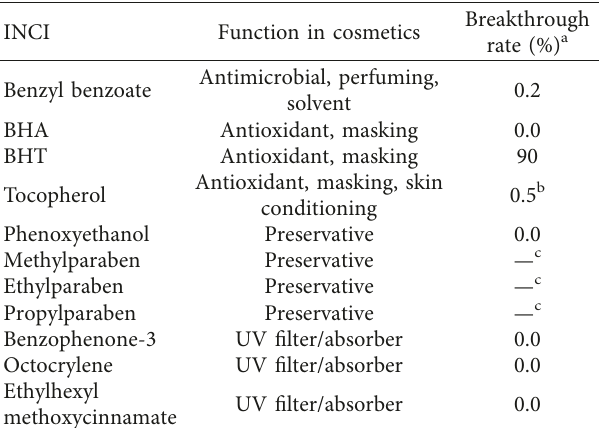
Table 9: Breakthrough rates of aromatic ingredients frequently used in cosmetics with signals in the chemical shift region in- tegrated for MOAH determination ( δ 9.3–6.5ppm) in 1 H NMR